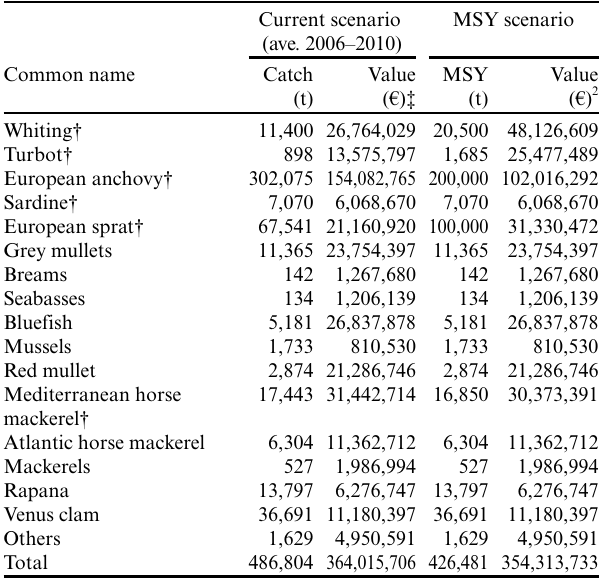
Table 5 . Estimated value added of current catches and catches under a maximum sustainable yield (MSY)